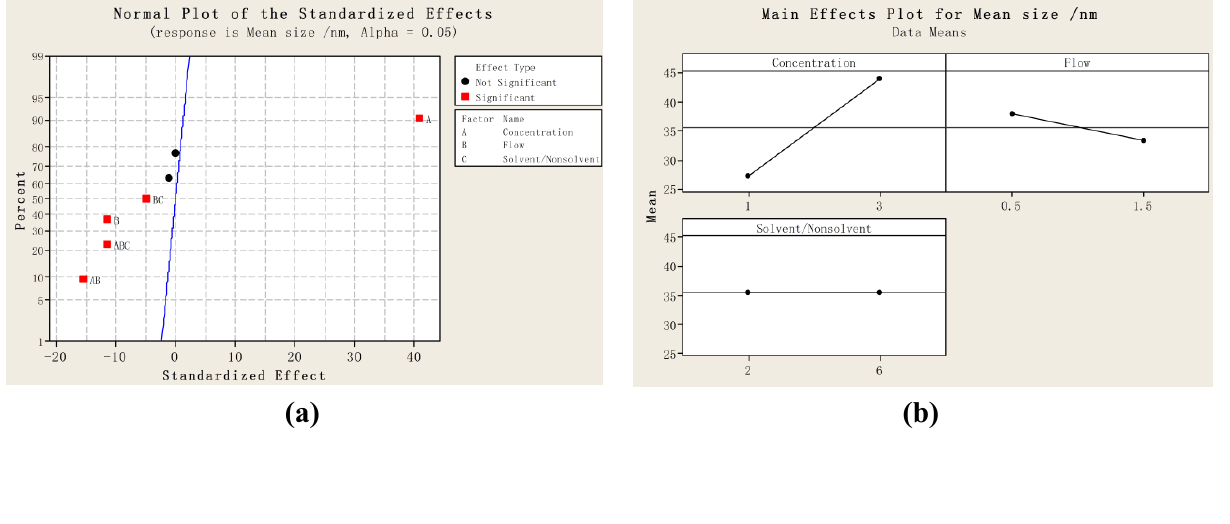
Figure 1. ( a ) Standardized effect of factors on mean size; ( b ) Main effects plot for mean size; ( c ) Standardized effect of factors on the span; and ( d ) Main effects plot for the span. ((A: the concentration of poly-(methyl vinyl ether-co-maleic anhydride) (PVM/MA) (%); B: Flow rate of PVM/MA solution (mL  min − 1 ); and C: solvent/nonsolvent